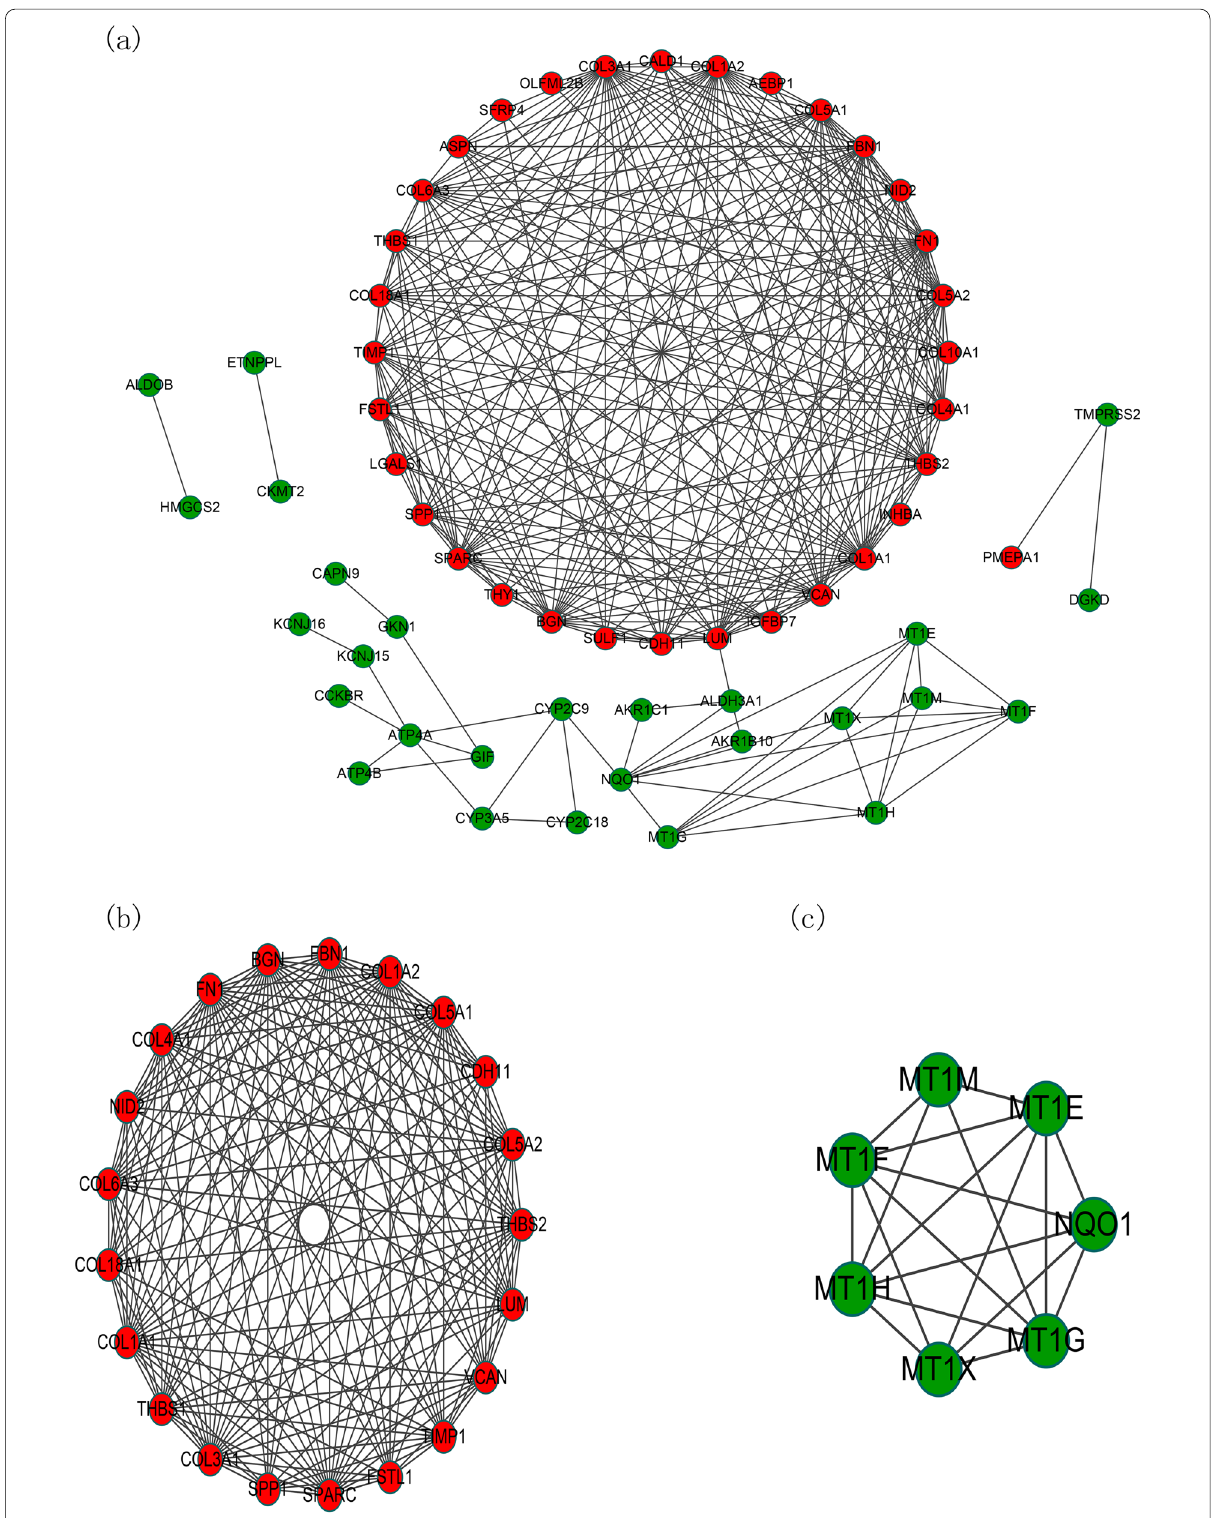
Fig. 2 Establishment of PPI network and modules analysis. a Entire PPI network. b PPI network of module 1. c PPI network of module